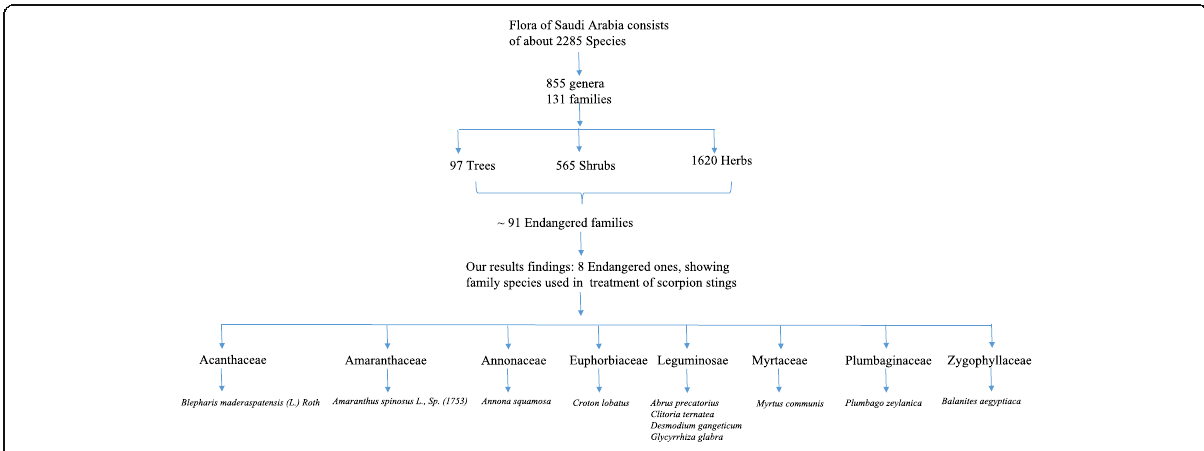
Fig. 12 Flow-chart showing endangered plant species used in treatment of scorpion